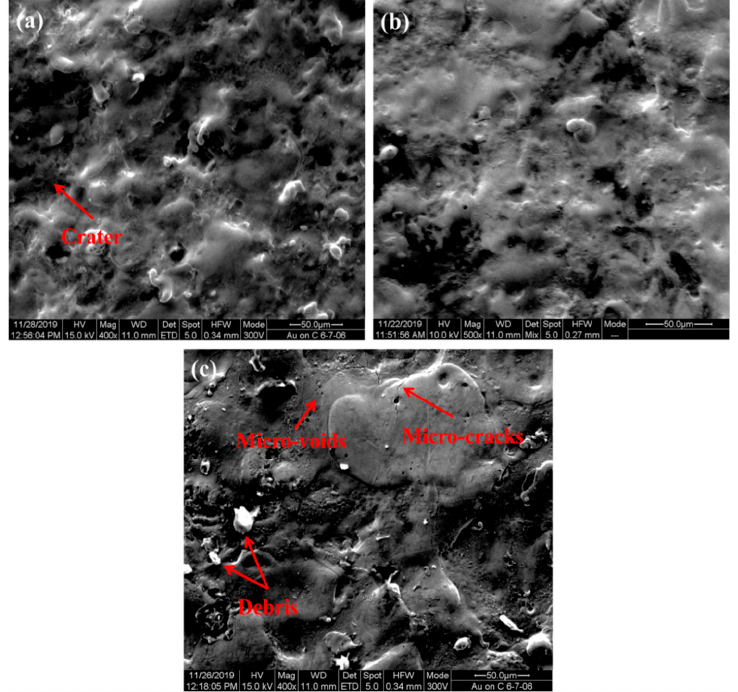
Figure 1. SEM micrographs of the machined surface ( a ) Ip = 5 A and Ton = 12.8 μ s, ( b ) Ι p = 7 A and Ton = 25 μ s and ( c ) Ι p = 9 A and Ton = 50 μ s.